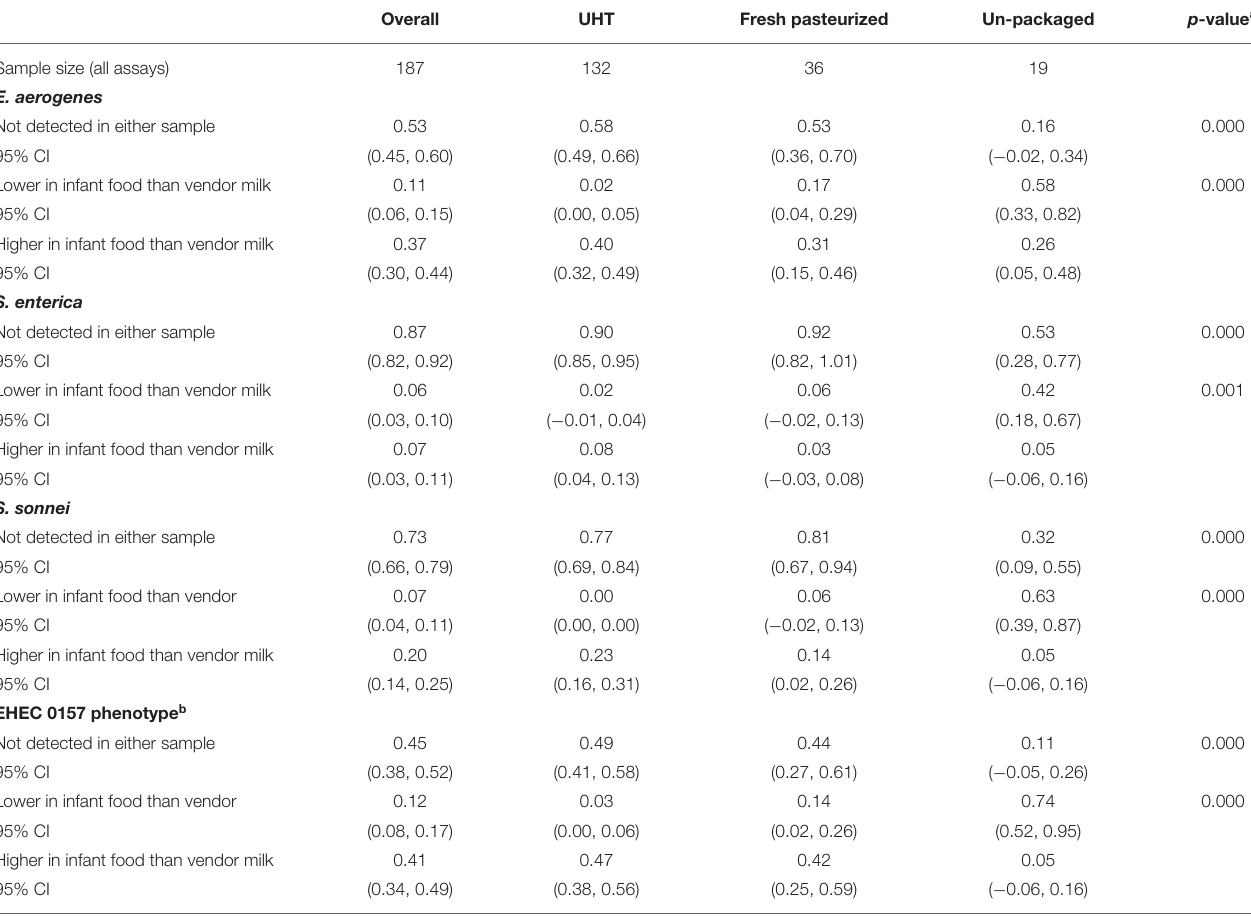
Overall UHT Fresh pasteurized Un-packaged p -value